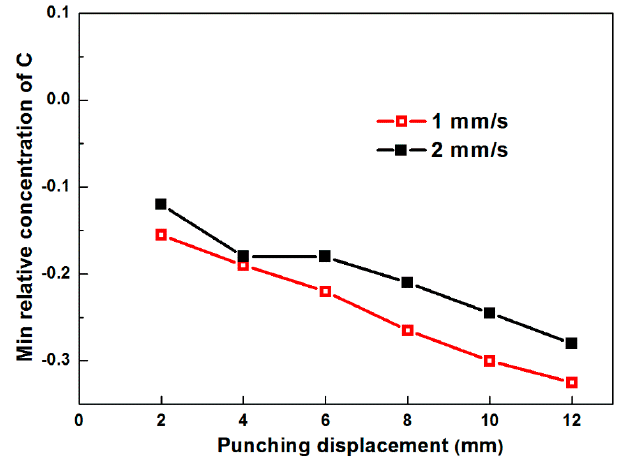
Figure 14. The evolution of the minimum relative concentration of C with punching displacement using different punching velocities.